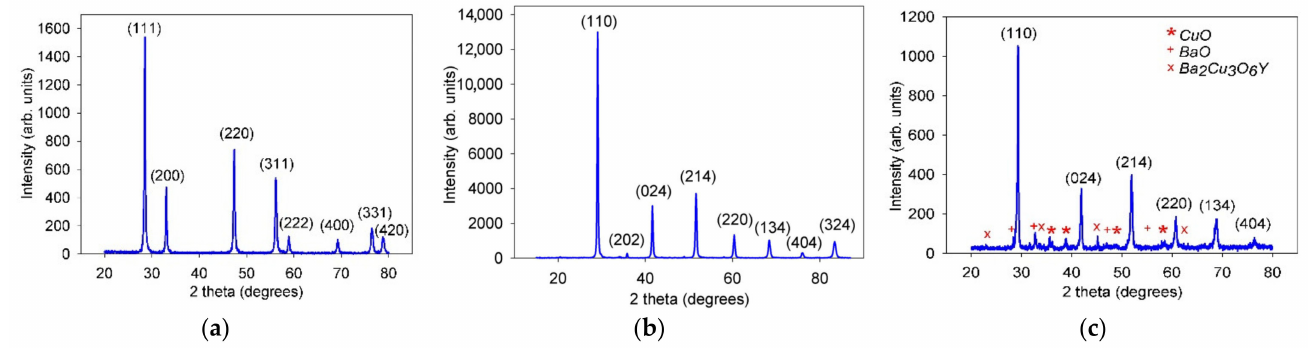
Figure 1. XRD patterns obtained for the electrolyte powders: ( a ) as-prepared SDC powder; ( b ) as-prepared BCZYYbO powder; ( c ) BCZYYbO-CuO powder (sintered at 1500 ◦